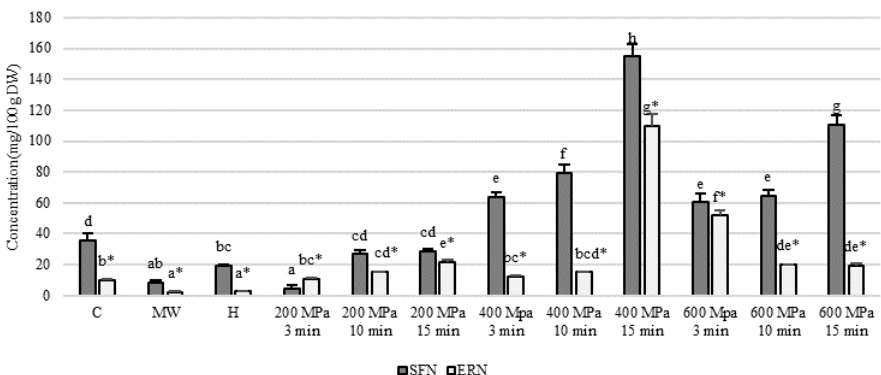
Figure 1. The sulforaphane (SFN) and erucin (ERN) contents of broccoli under different conditions. C: control (untreated); MW: microwave treatment (800 W, 3 min); H: hot water treatment (100 ◦ C, 3 min). The same symbols, noted as superscripts after the letter, means that the ANOVA performed is in the same group. Bars carrying different letters are statistically different at p <